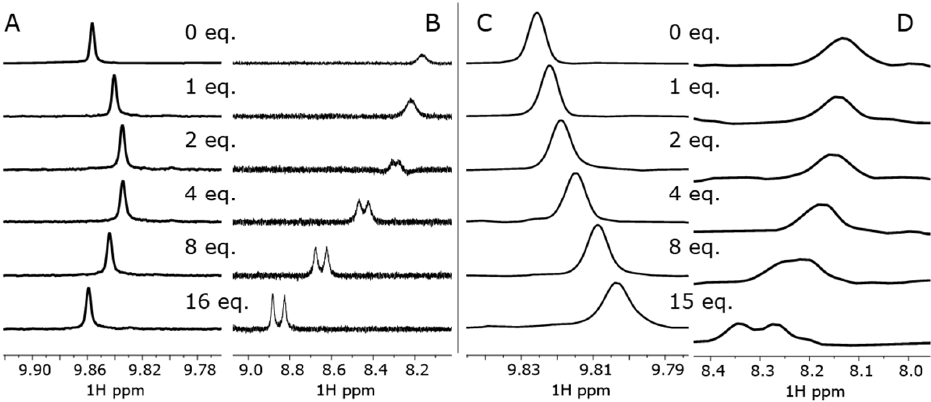
Figure 2. 1 H-NMR spectra of bis–ZnOEP upon addition of cycHC[6] in CD 2 Cl 2 : signals of ( A ) meso - α protons and ( B ) meso - β protons; and upon addition of cycHC[8] in CH 2 Cl 2 and 10% CDCl 3 : signals of ( C ) meso - α and ( D ) meso - β protons.